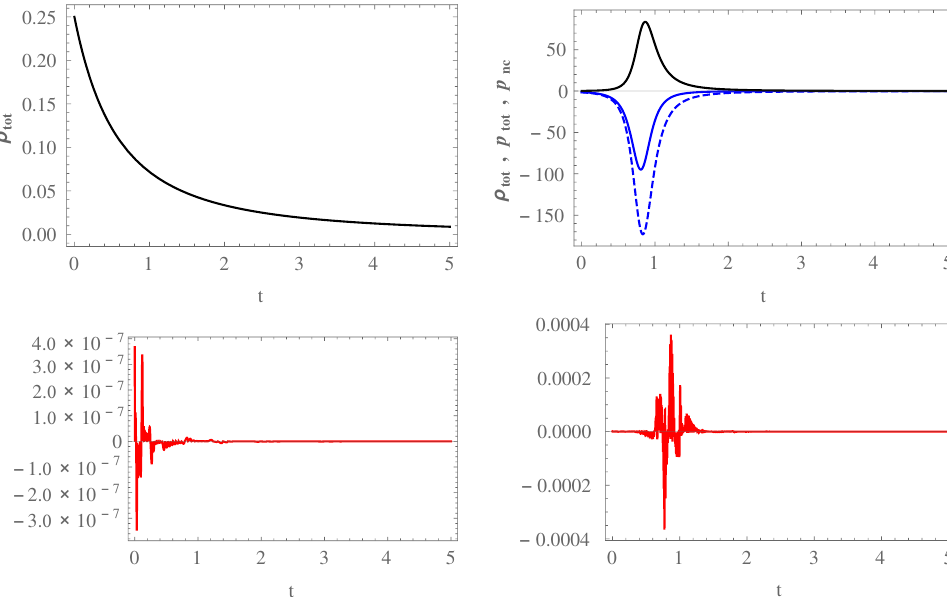
Figure 2. The behavior of the total kinetic energy (black curves), total pressure (solid blue curve), and NC pressure (dashed blue curve) against cosmic time for the commutative case ( upper left panel ) and NC case ( upper right panel ). Moreover, the lower left panel and lower right panel are shown the numerical error concerning satisfying the conservation Equation (22) for the commutative case and NC case, respectively. The values for the initial conditions, parameters and units are equal to the corresponding ones chosen for the Figure 1.